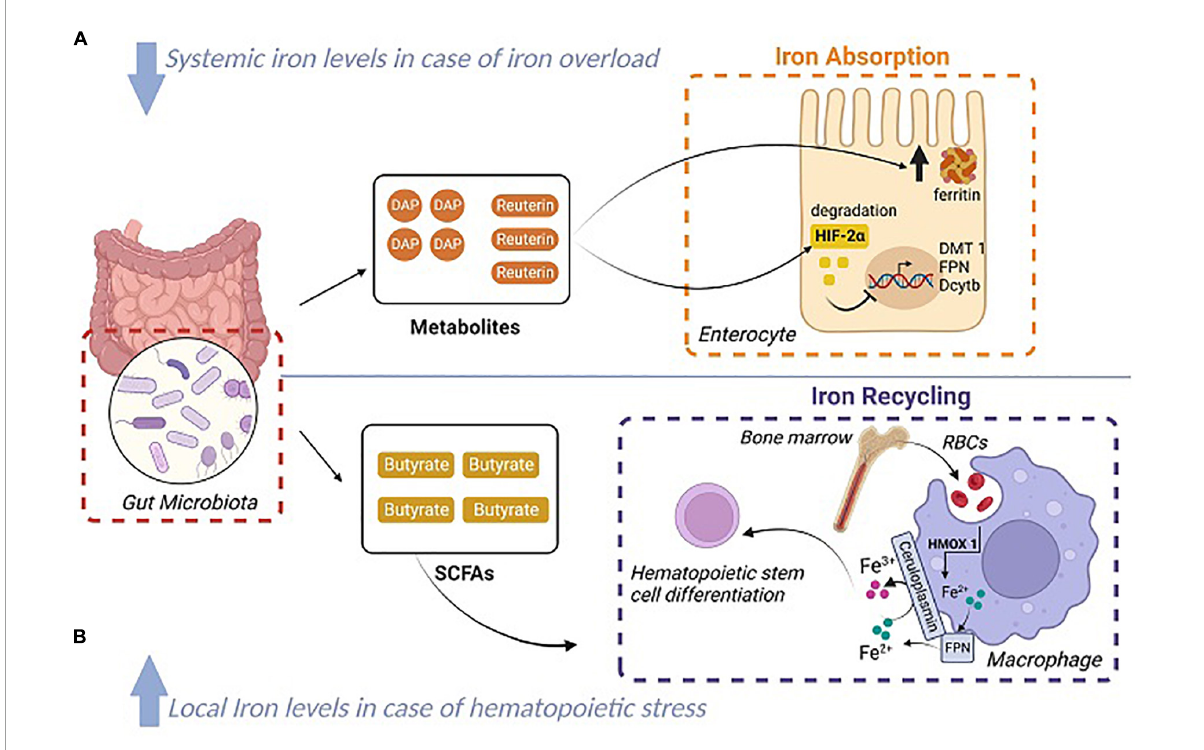
FIGURE2 Summary of the achieved relationship between the gut microbiota and systemic/local iron levels. (A) The gut microbiota releases 1,3 diaminopropane (DAP) and reuterin in case of iron overload and decreases systemic iron levels. DAP and reuterin induce ferritin expression, and cause the degradation of HIF-2 α consequently blocking the expression of the iron transporters (Dcytb, DMT1, and FPN). (B) Hematopoietic stress leads to the release of butyrate by the gut microbiota. Butyrate decreases local iron levels by promoting iron recycling (erythro-phagocytosis) in order to allow hematopoietic stem cells differentiation. ©Created with